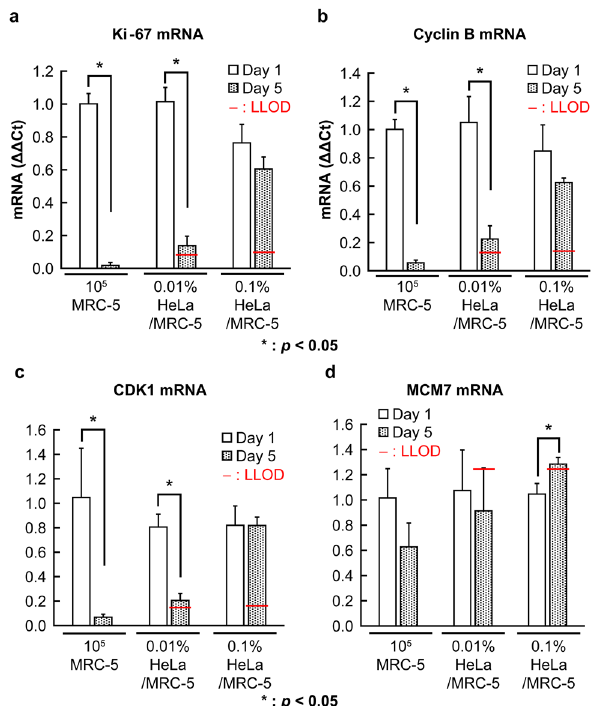
Figure 2. Changes in the cell cycle-related mRNAs in each group for the short-term culture. The mRNA expressions at day 1 and 5 after seeding in soft agar. ( a ) The expression of Ki-67 mRNA, ( b ) The expression of cyclin B mRNA, ( c ) The expression of CDK1 mRNA, ( d ) The expression of MCM7 mRNA. Bars represent means ± standard error of the mean. n = 3 samples. * P < 0.05, unpaired two-tailed t -test. The lower limit of detection (LLOD) is set as the mean expression of MRC-5 at day 5 ± 3.3 × SD. CDK1, cyclin-dependent kinase 1; MCM7, minichromosome maintenance protein